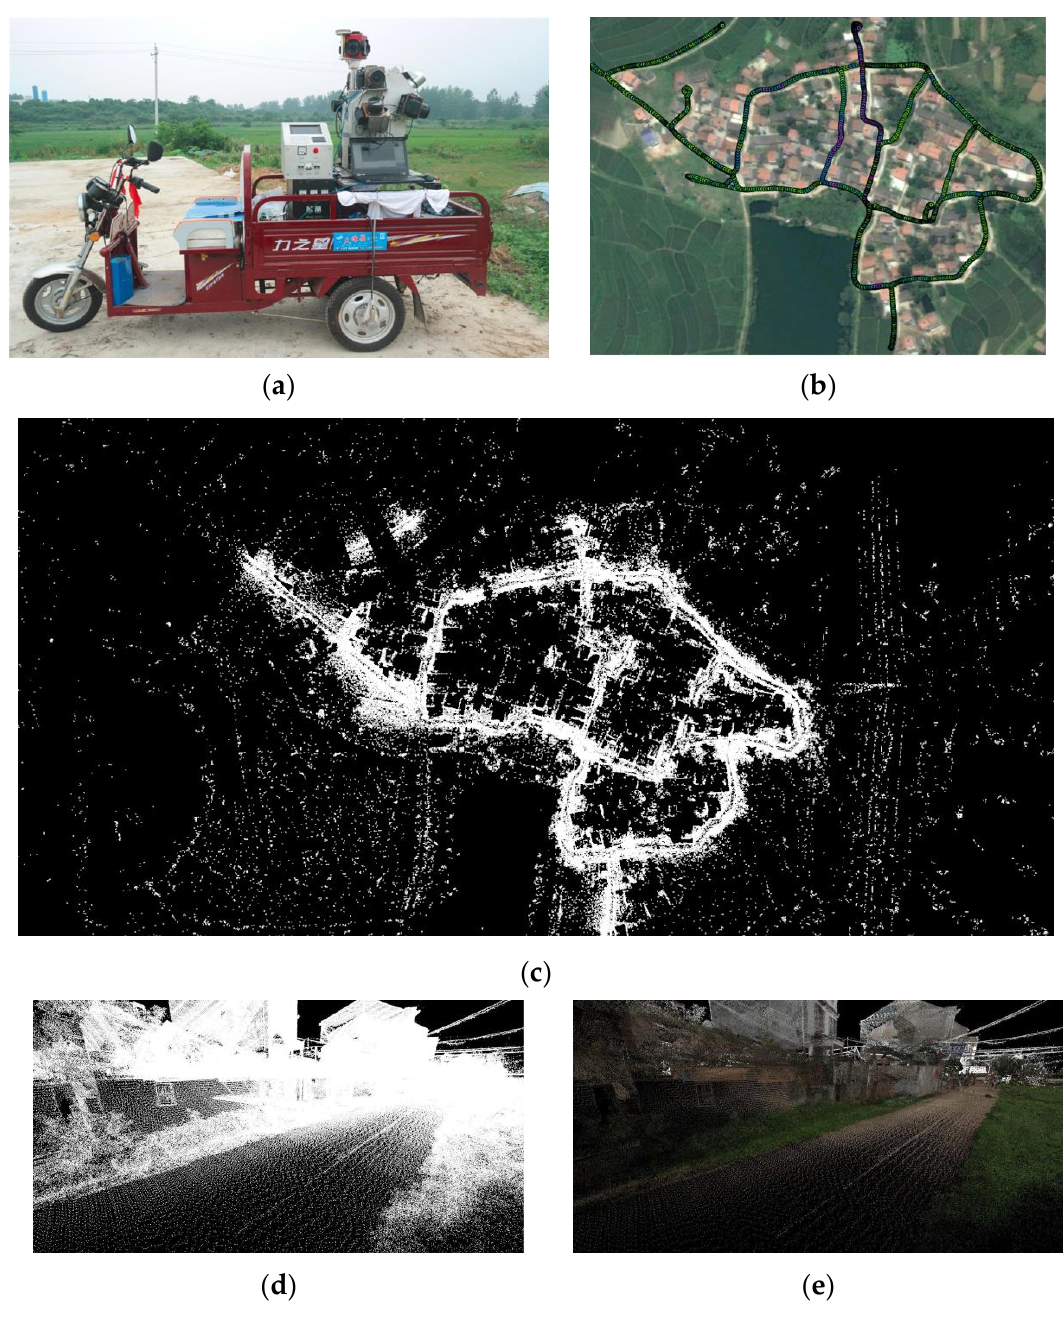
Figure 2. ( a ) electro-tricycle MTLS set up for Ma’anshan Village; ( b ) the driving route around the village; ( c ) the electro-tricycle MTLS data of the village; ( d ) a close-up view of the collected MTLS data; and ( e ) colored MYLS data of ( d ).